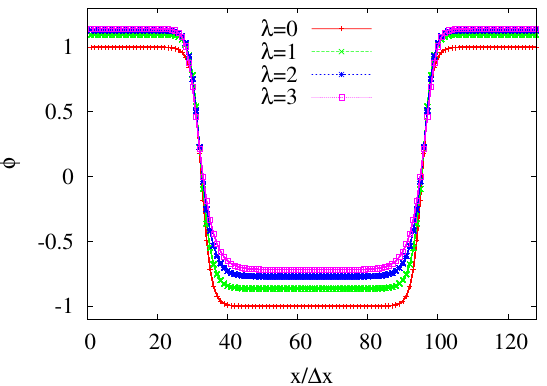
Figure 1. Steady density profiles for different values of the parameter λ .